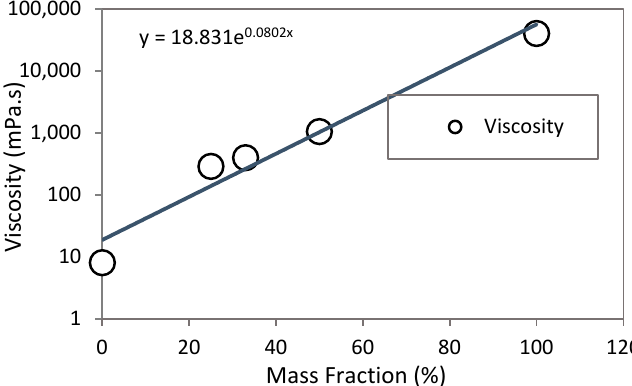
Figure 7. How bitumen mass fraction affects mixture viscosity.